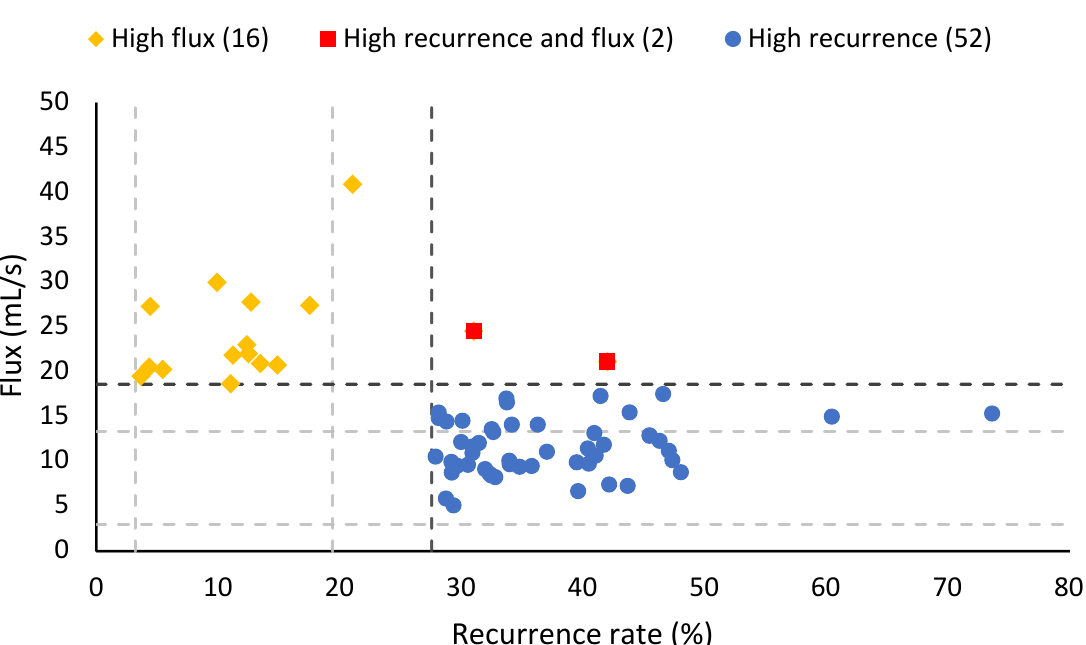
Figure 12. Distribution of seep flux and recurrence rates exhibited by the subset of more oily and more active seep zones. The light gray dashed lines indicate rates that are ± 1 SD and the dark gray dashed lines indicate rates that are +2 SD.